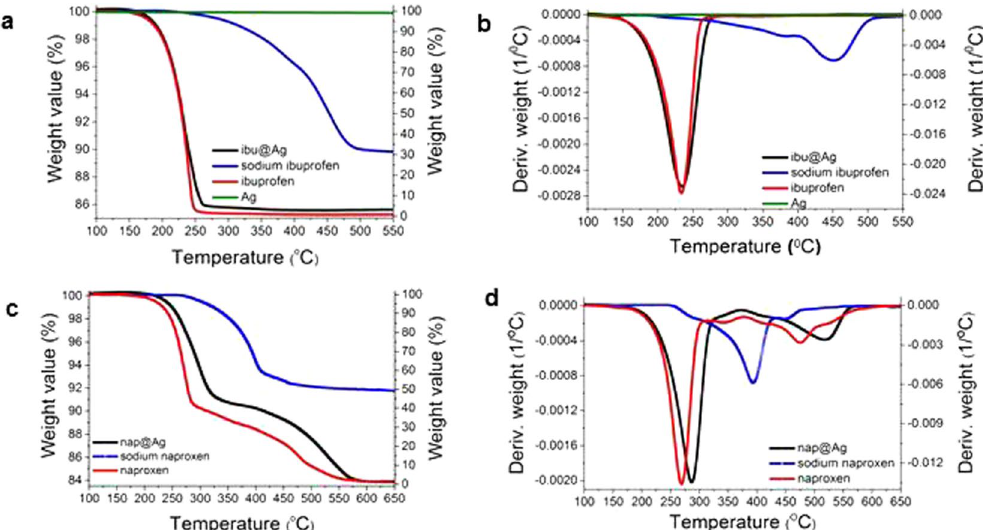
Figure 2. The weight loss vs. temperature (TGA) and the weight loss first derivative graphs of the composites and of the pure components. ( a ) and ( b ): ibu@Ag (black line, left axis) and Ag (green line, left axis), sodium ibuprofen (in blue, right axis), ibuprofen (in red, right axis). ( c ) and ( d ): nap@Ag (in black, left Y axis), sodium ibuprofen (in blue, right axis), ibuprofen (in red, right